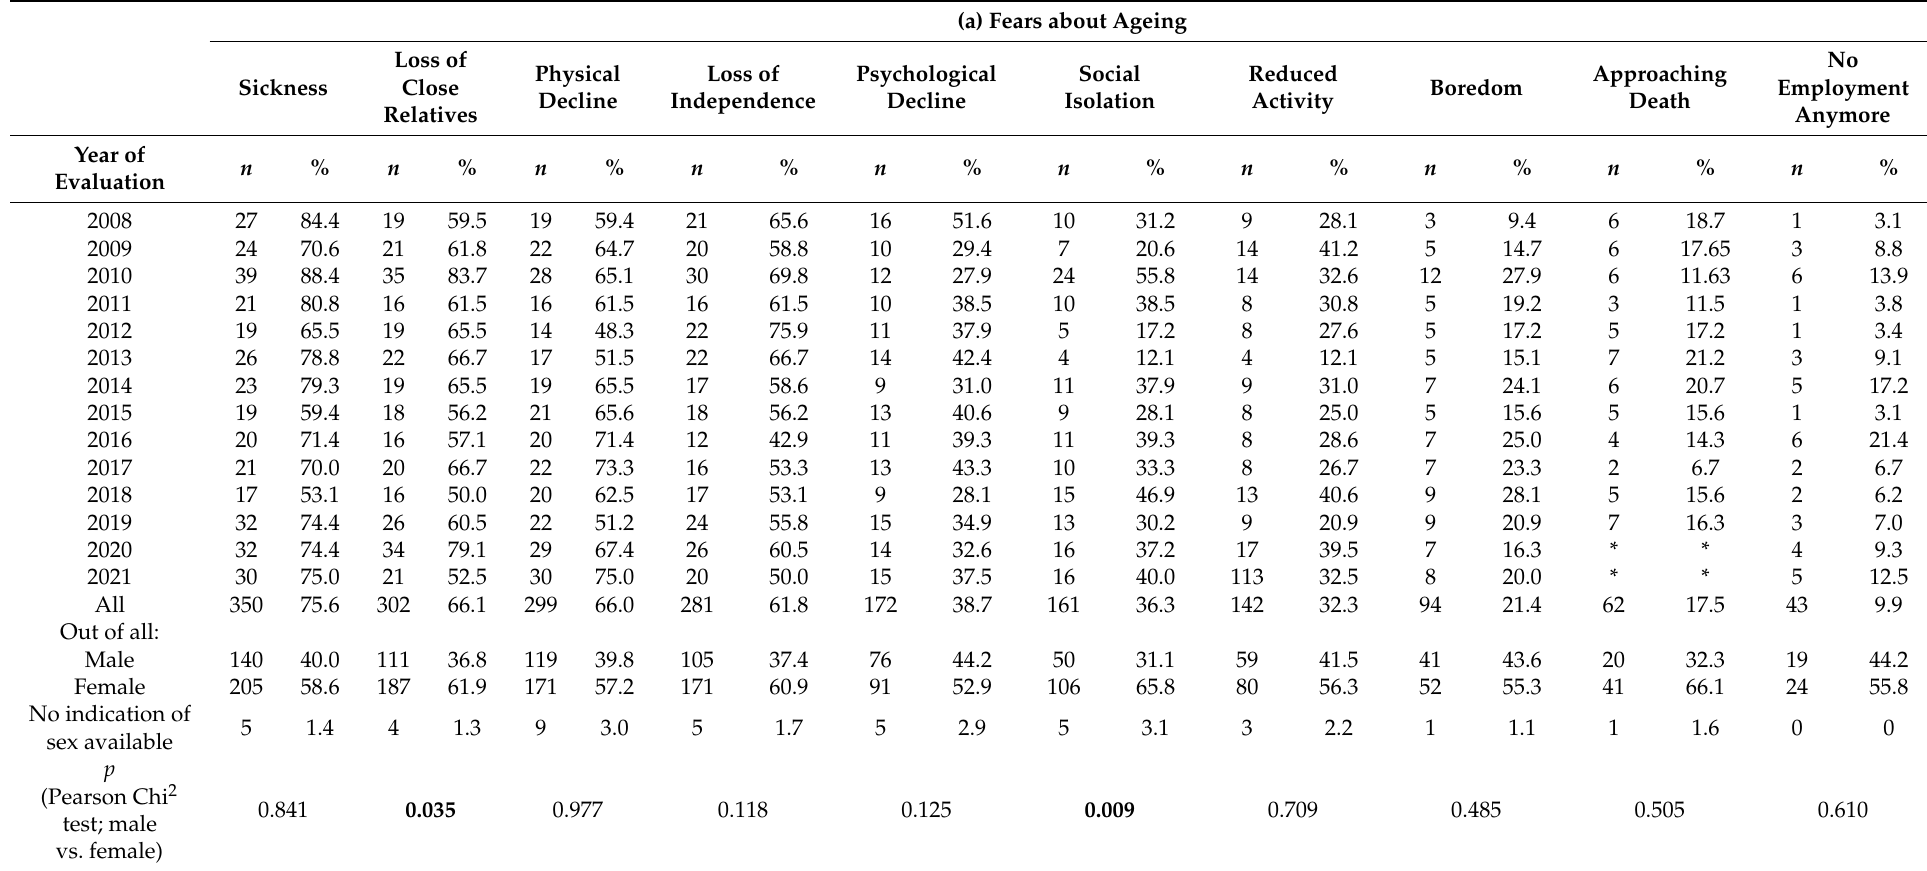
Table 3. Student (a) fears and (b) hopes about ageing by year, and «All» by gender. (* data not assessed in 2020/2021) (multiple answer possible) (bold values indicate p ≤ 0.05) (based on data from (23) and